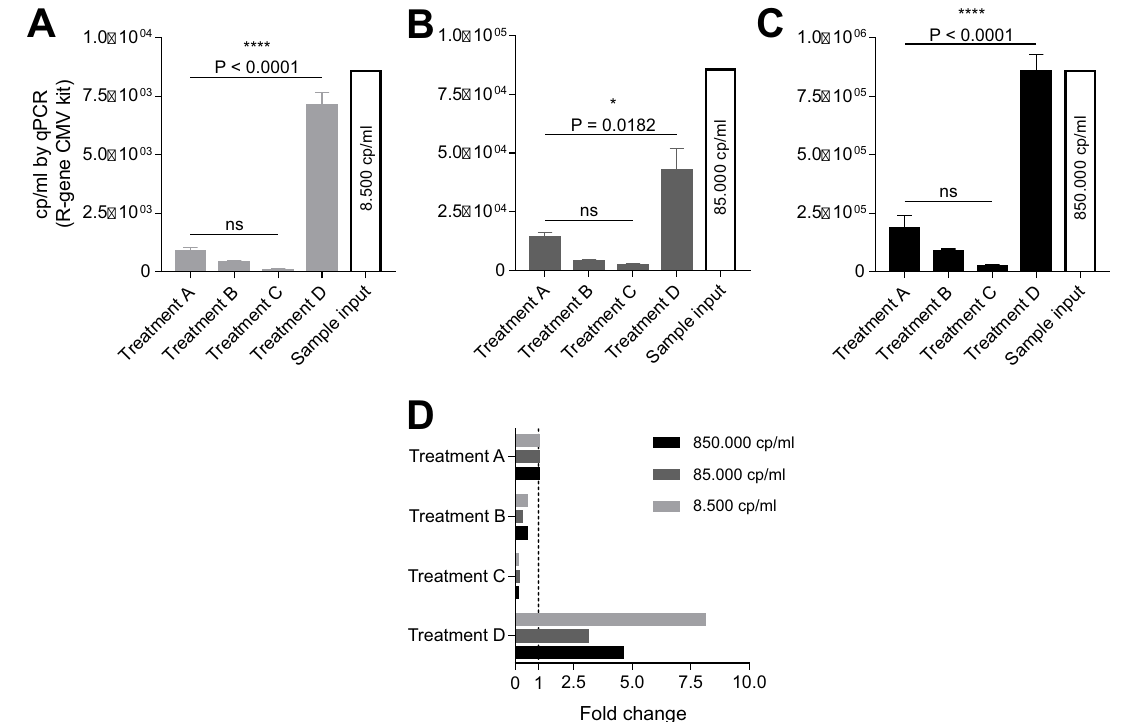
Fig 2. Extraction of CMV DNA from dried blood spots using four different methods. (A-C) Extraction of CMV DNA from two 3.2 mm diameter filter paper discs punched from dried blood spots with different CMV concentrations. (D) Relative extraction yield of the different treatments compared to the reference treatment (treatment A). P values were determined by one-way ANOVA; ns = not significant. n =